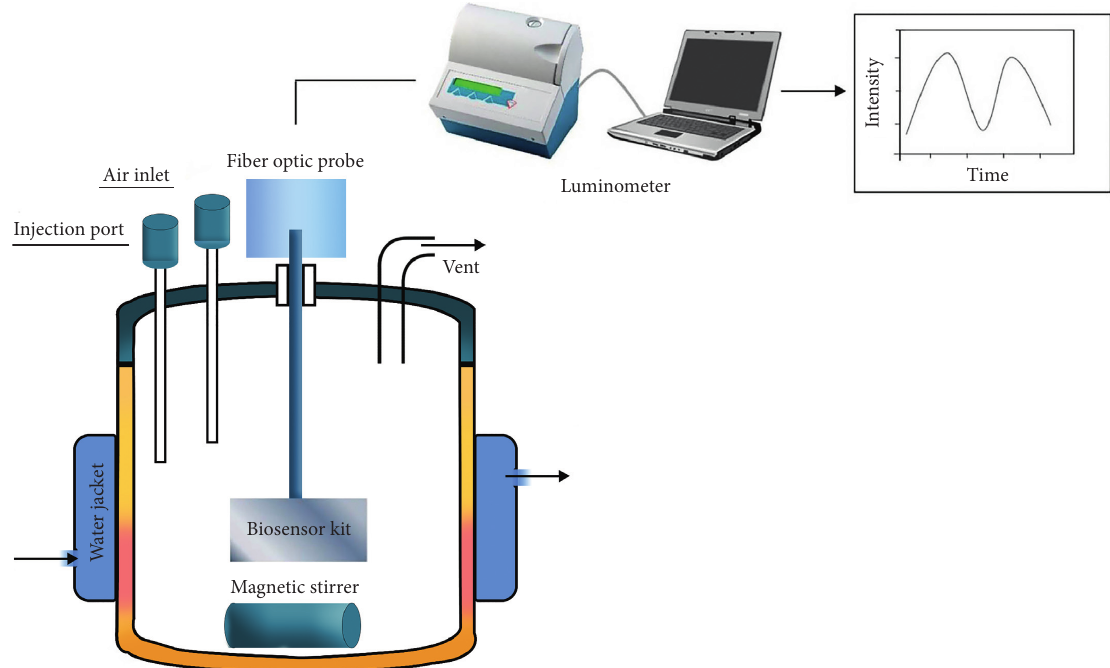
Figure 3: Biosensor system used in this study.